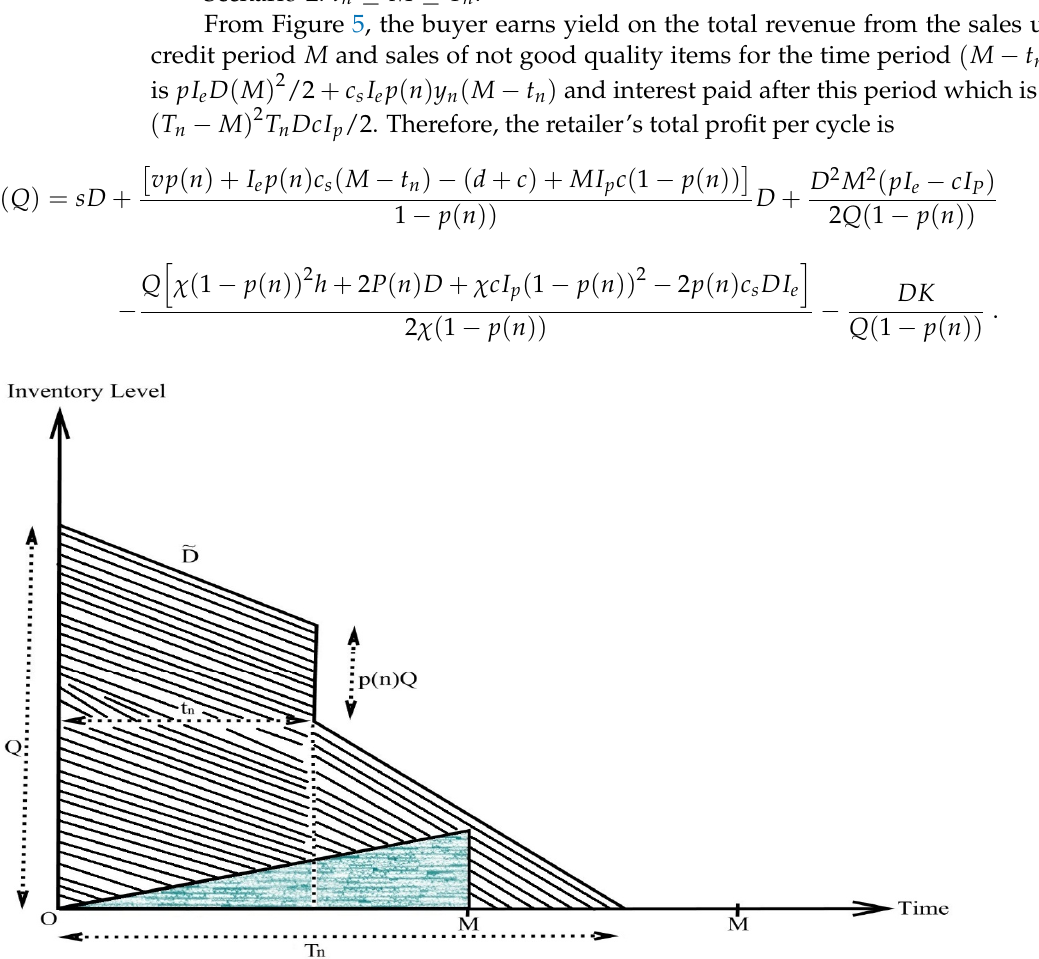
Figure 5. Inventory with time for Scenario-2.